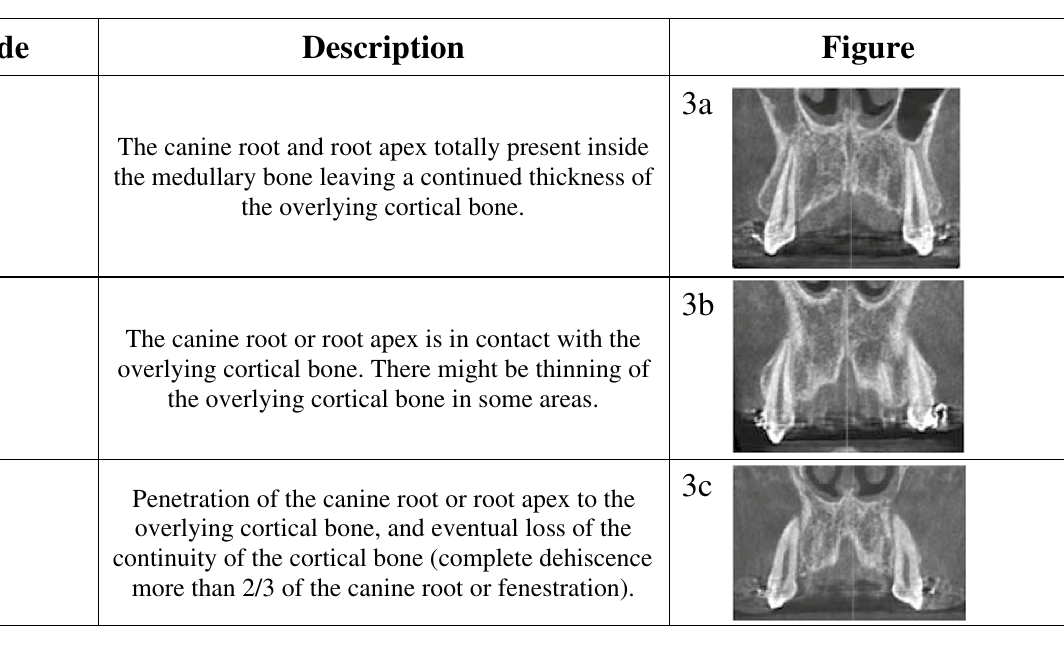
Table 1. Classification of the root/cortical bone relation.